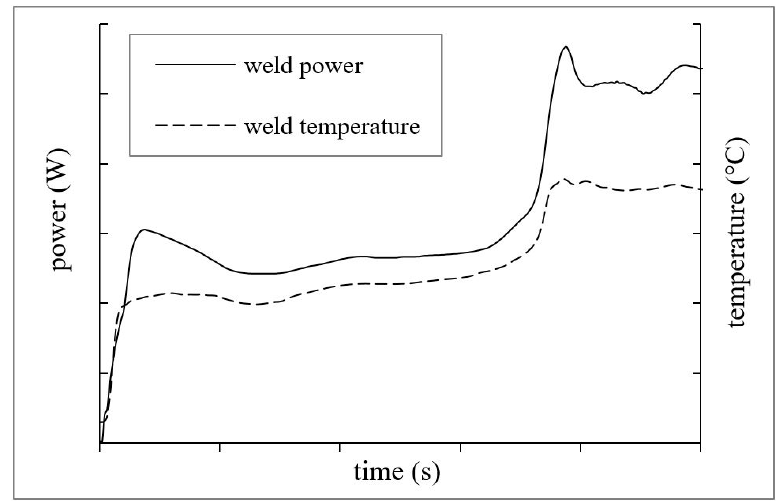
Figure 2. An example plot of the weld power and the weld spot temperature as functions of time for an exemplary ultrasonic spot weld applied on a carbon fiber-reinforced thermoplastic laminate pair.